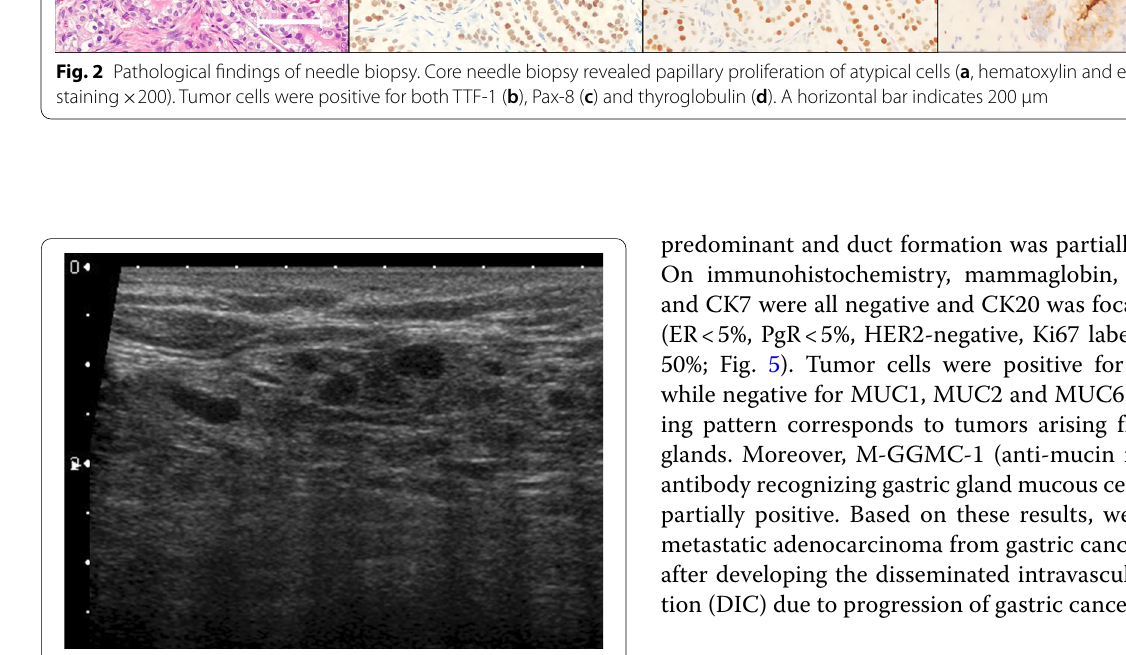
Fig. 3 Ultrasound findings of case 2. Ultrasound showed a hypoechoic area with unclear boundaries including cysts and the internal echo level was uneven